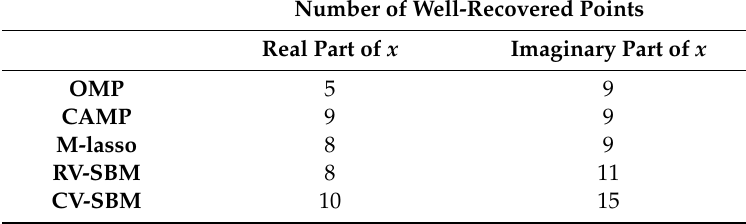
Comparison of recovery performance by OMP, CAMP, M-lasso, RV-SBM, and the proposed